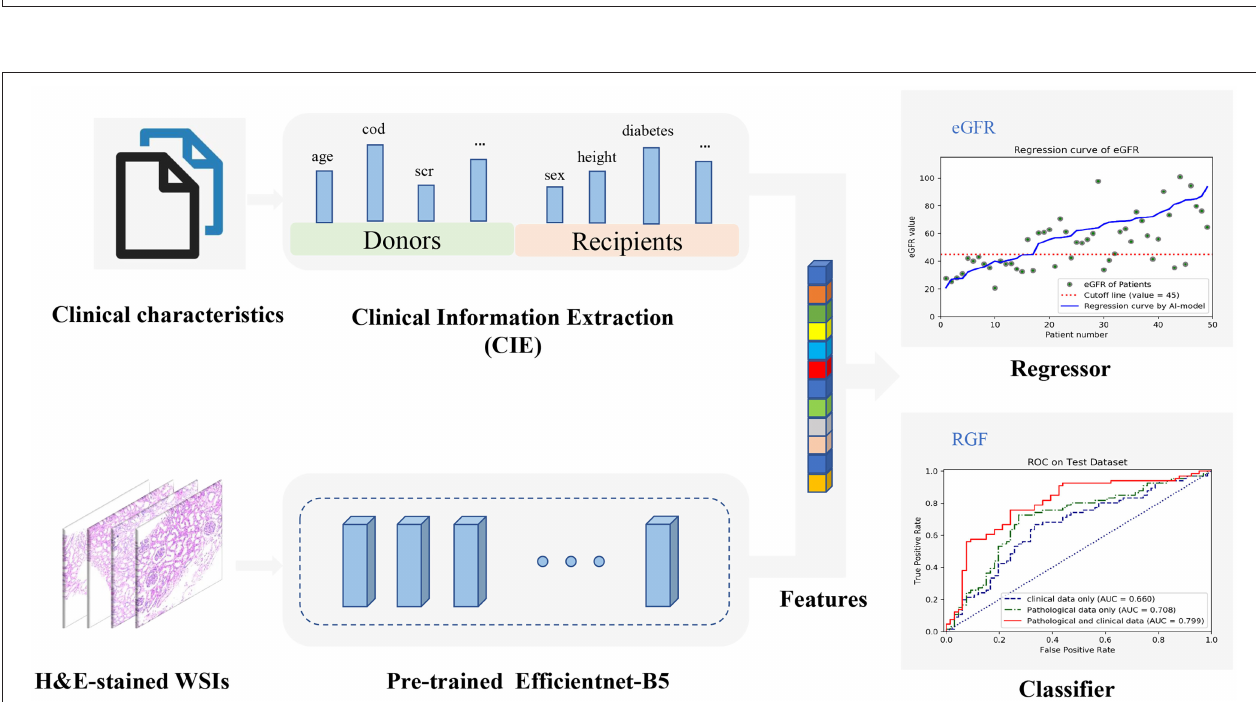
FIGURE 2 | The overall workflow diagram of the model. H&E-stained whole-slide images (WSIs) are fed into the parallel pretrained Efficientnet-B5 model to extract features automatically which can be combined with all clinical information encoded from clinical texts. Then, the combined features can be used to construct a regression model to predict estimated glomerular filtration rate (eGFR) values and a classifier to predict reduced graft function (RGF), simultaneously.